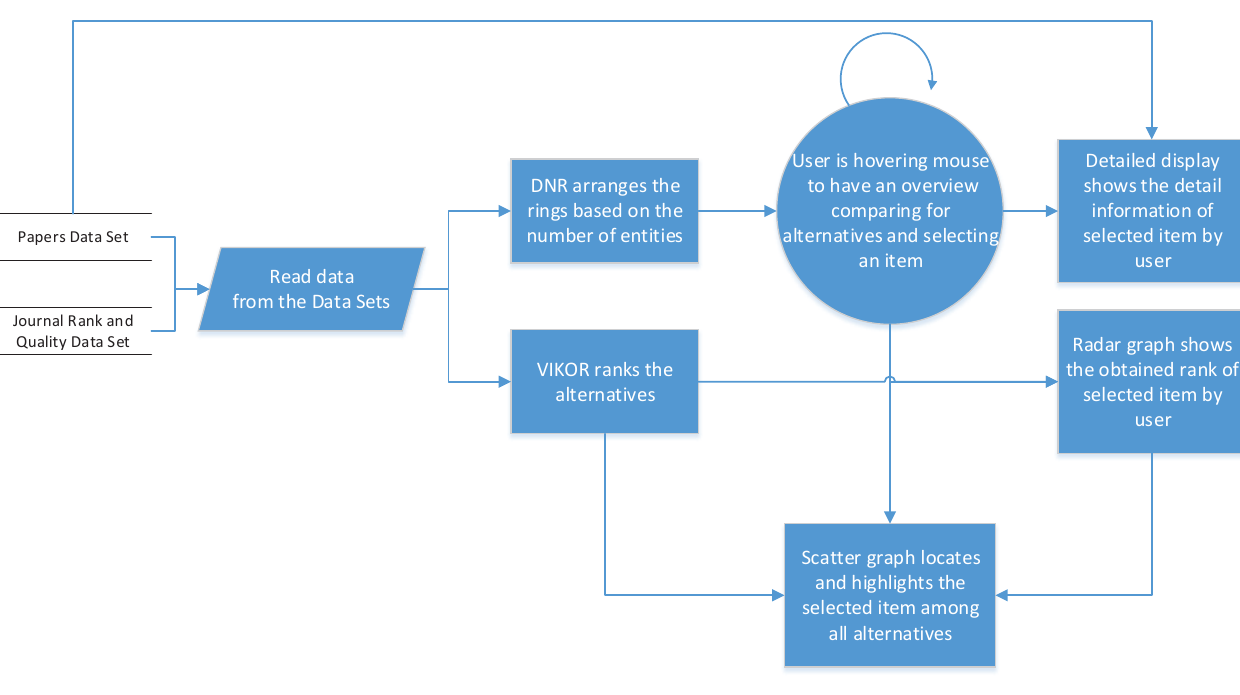
Figure 4. Work follow of application in level